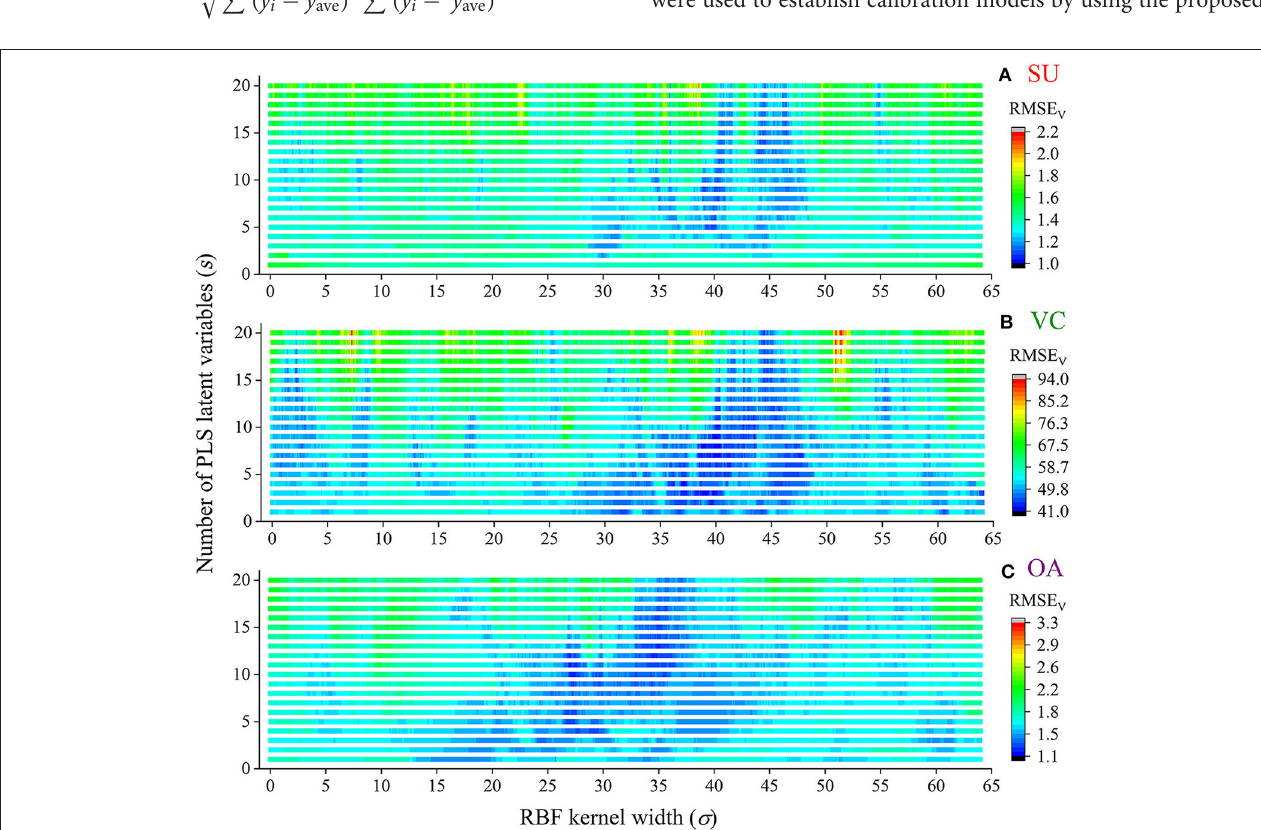
FIGURE 4 | The combined deep tuning of RBF kernel width ( σ ) and the number of PLS latent variables ( s ) for the optimization of the NIRHI calibration model ( A–C are for the prediction of SU, VC, and OA, respectively).